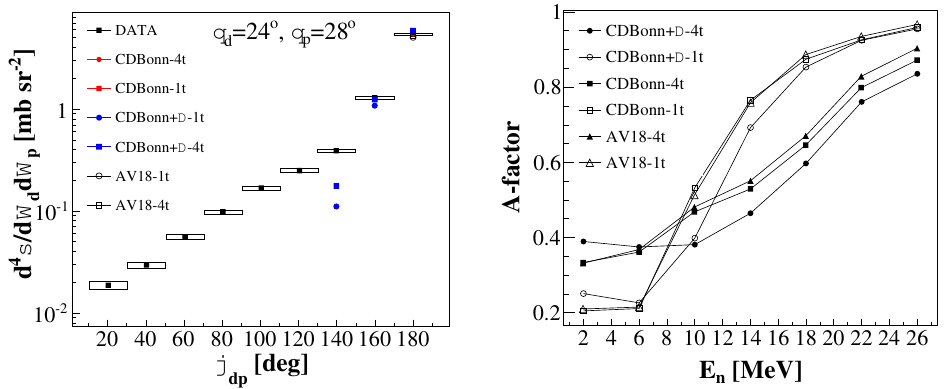
, for a given θ , θ com- dp d p . n